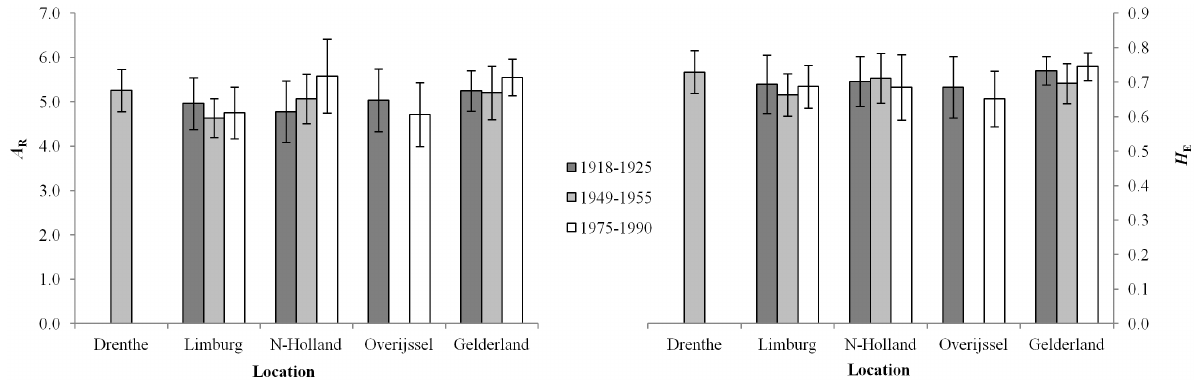
Fig 2. Genetic diversity of the Bombus pascuorum populations. The mean allelic richness ( A R ) and expected heterozygosity ( H E ) averaged across loci (and S.E.) between the B . pascuorum populations over the different locations and the three time periods.